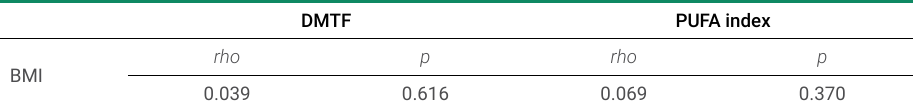
Table 5. Correlation between BMI and caries experience and its clinical consequences when not treated. DMTF PUFA